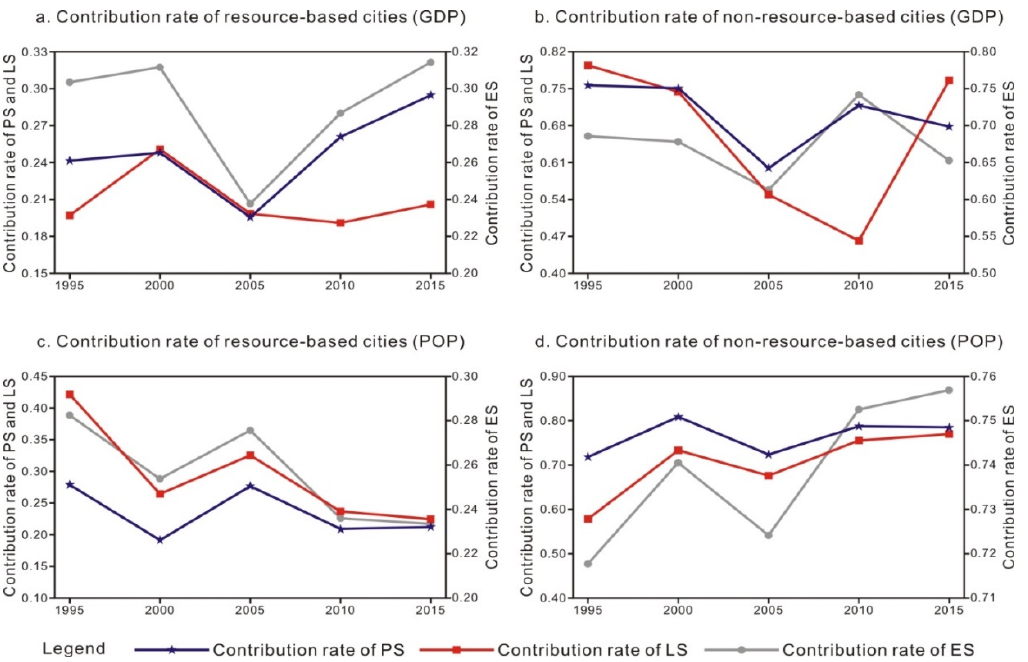
Figure 7. Change trend of the contribution rate of the PLES-related Theil index, 1995–2015. Note: The left ordinate indicates the PS and LS, and the right ordinate indicates the ES.